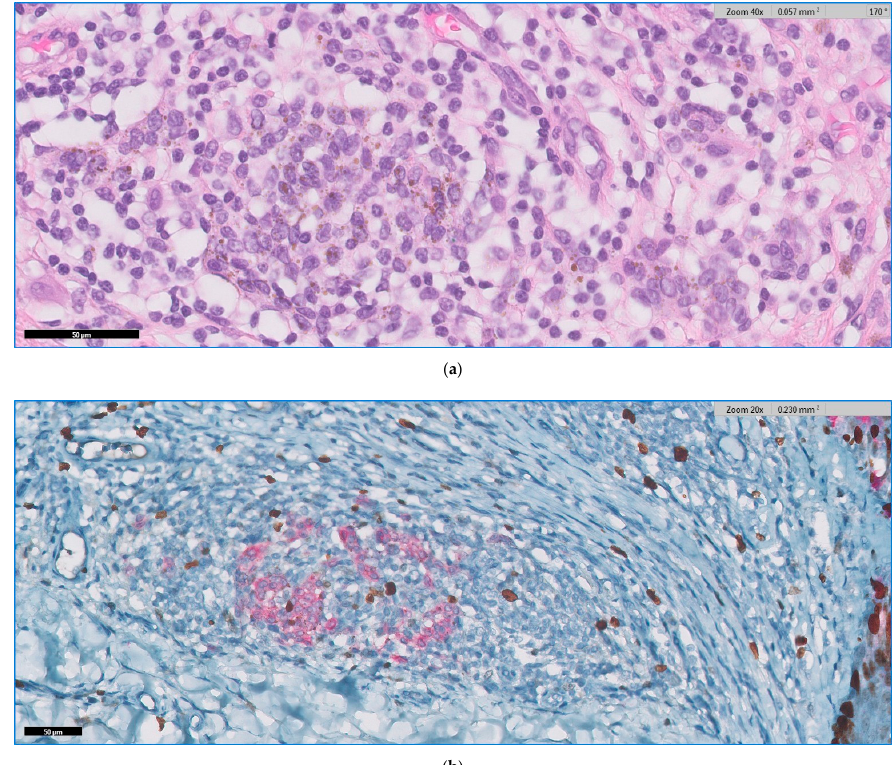
Figure 7. ( a ) HE and ( b ) Ki67 ‐ Mart1 dual stain. The halo phenomenon showing lymphocytic inflammation intermigled with benign nevus cells. There are many diseases that have been described in individuals with Sutton nevi, such as vitiligo, thyroid diseases, and neoplasia [18,19,37,38]. Among them, vitiligo is the most frequently seen [19]. The association with malignant diseases needs further investi ‐ gation. Even though studies have focused on finding out whether patients with halo nevi are susceptible to developing vitiligo, a consensus is lacking. When associated with vitiligo, halo nevi tend to appear earlier in life [18,37]. In other words, the lower the age of the patient with halo nevi, the greater the risk of developing vitiligo. The idea that multiple halo nevi rather than a single lesion associate with vitiligo was suggested by many authors in studies involving children [39] and adults [37]. On the other hand, van Geel et al. con ‐ sidered that the risk of vitiligo decreased when the number of halo nevi was greater than three [18].